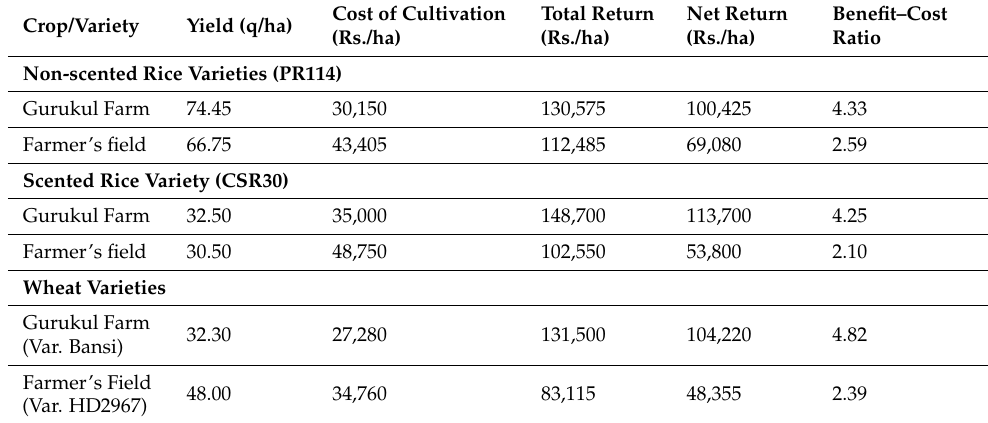
Cost of Cultivation Total Return Net Return (Rs./ha) (Rs./ha) (Rs./ha)